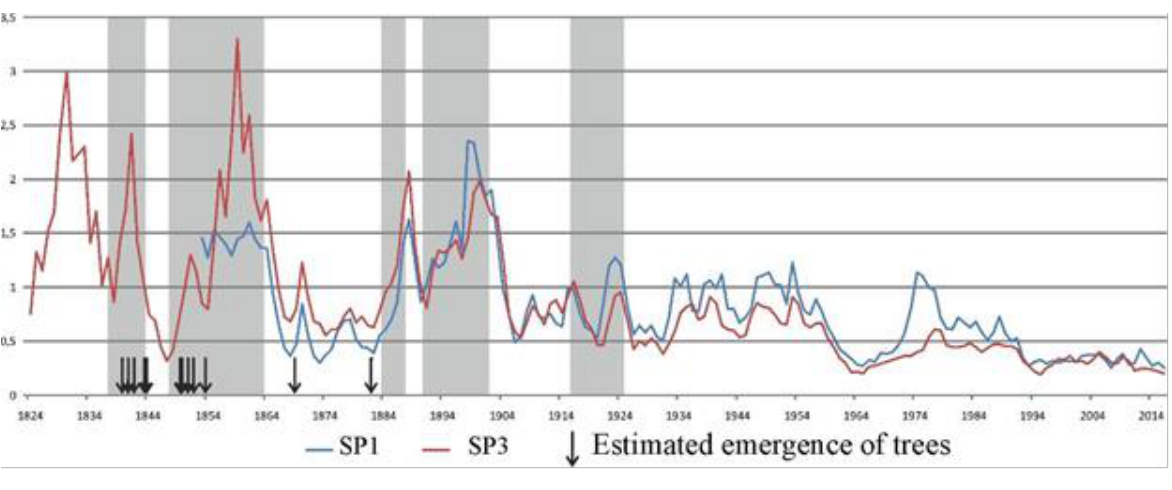
Figure 6. Generalised pine chronologies for Sample Plot 1 and Sample Plot 3. Grey bars mark periods with low (< 500 mm per year) precipitation; no preceipitation data were available before the year